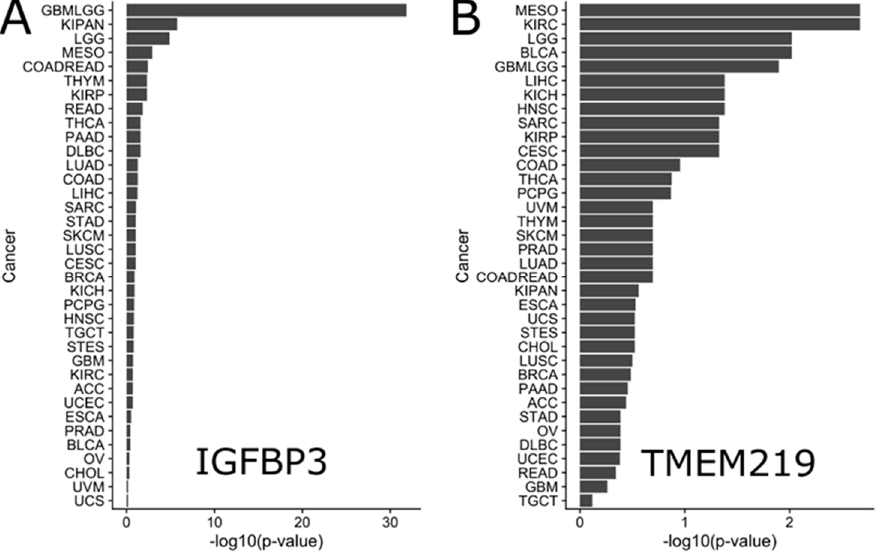
Figure 5. Survival effect of IGFBP-3 ( A ) and TMEM219 ( B ) in various cancers. Larger size of each bar corresponds to the more significant effect on survival.